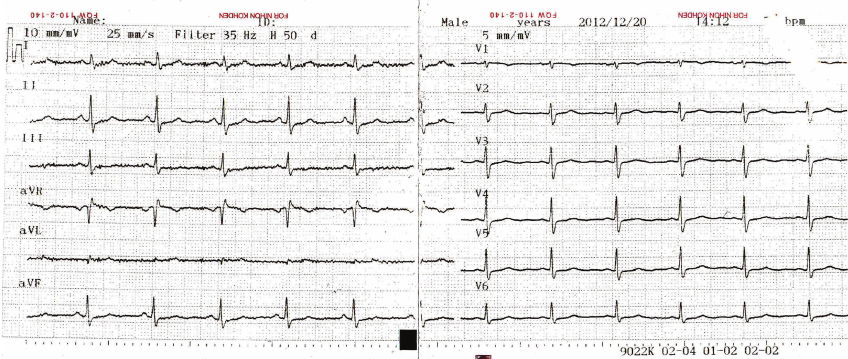
Figure 3: Four weeks after starting steroid and thyroid replacement therapy, twelve-lead electrocardiogram demonstrates normal QT